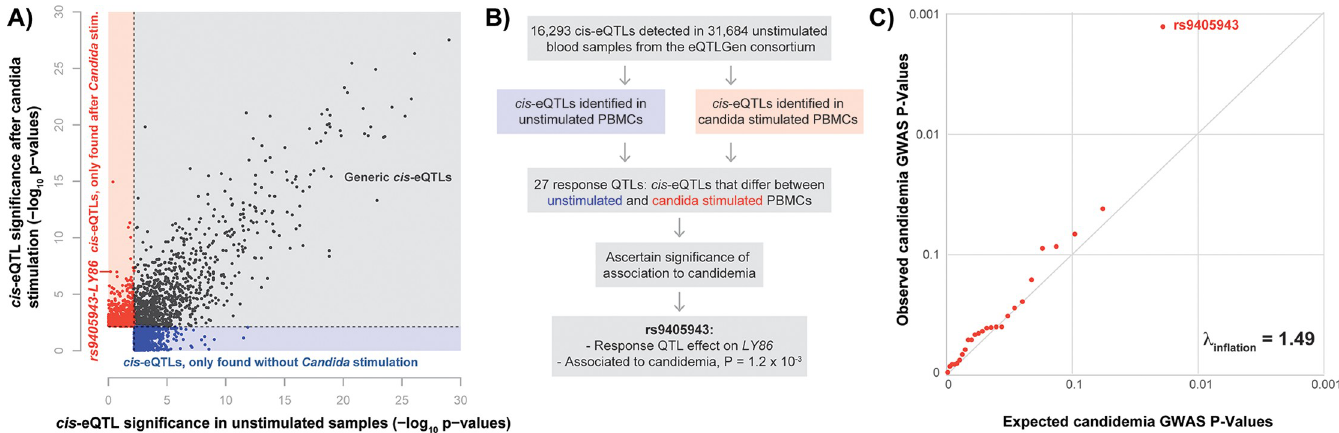
Fig 2. Integration of GWAS with eQTL analysis allows for prioritization of potential key driver genes. (A) Comparison of -log10 p-values of identified eQTLs in individuals without Candida stimulation (n = 75) and eQTLs identified in individuals after Candida stimulation (n = 72). Red points show eQTLs that are significant only with Candida stimulation, blue points show eQTLs that are significant only without Candida stimulation and black points depict eQTLs that are significant in both conditions. The eQTL analysis was restricted to top SNP-gene combinations identified in the eQTLGen consortium [23]. (B) The performed work flow to identify potential key driver genes in Candida response. (C) QQ-plot of 27 Candida -response QTL SNPs in a GWAS on candidemia susceptibility, comparing expected GWAS P-values (x-axis) with observed GWAS P-values (y-axis). The dots show deviation from the expected line ( ƛ inflation = 1.49) with the strongest GWAS association found for